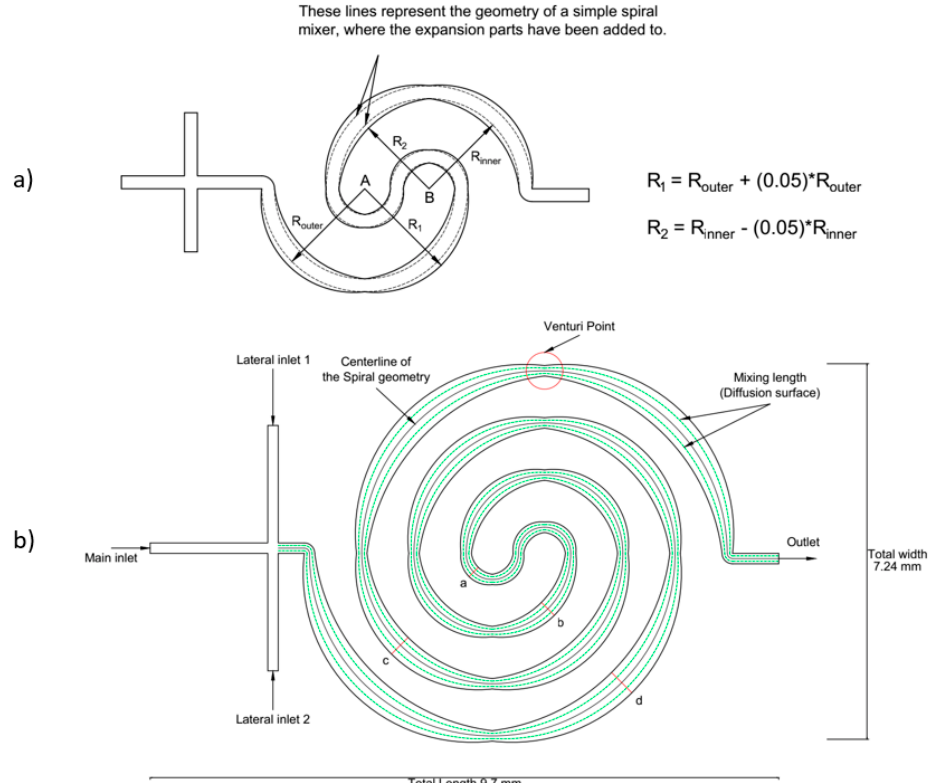
Figure 1. ( a ) Conceptual diagram of the proposed one loop class micromixer, where Rinner and Router represent the radius of inner and outer walls of the basic design of the spiral mixer. ( b ) Schematic view of the three loops mixer with 5% expansion. The width of the channel at the cross-sections a, b, c and d is 250, 350, 450 and 550 µ m,